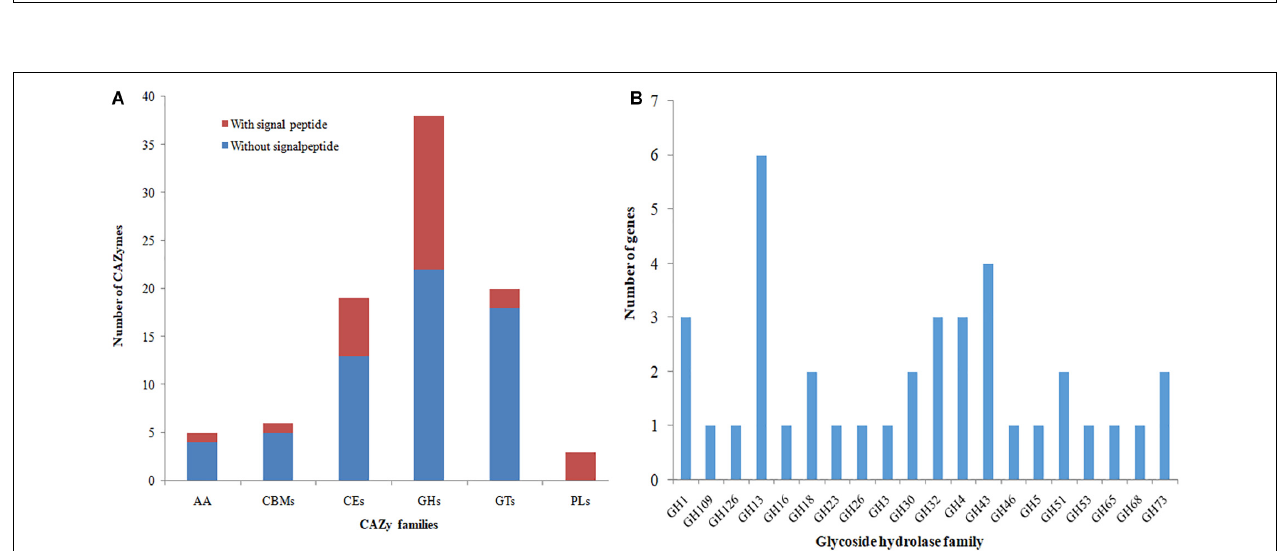
FIGURE 7 | Distribution of CAZy families in the genome of strain YB-130. (A) Gene count distributions of carbohydrate-active enzyme (CAZy) families in the YB-130 genome; (B) Functional characterization of glycoside hydrolase family is based on the CAZy database.